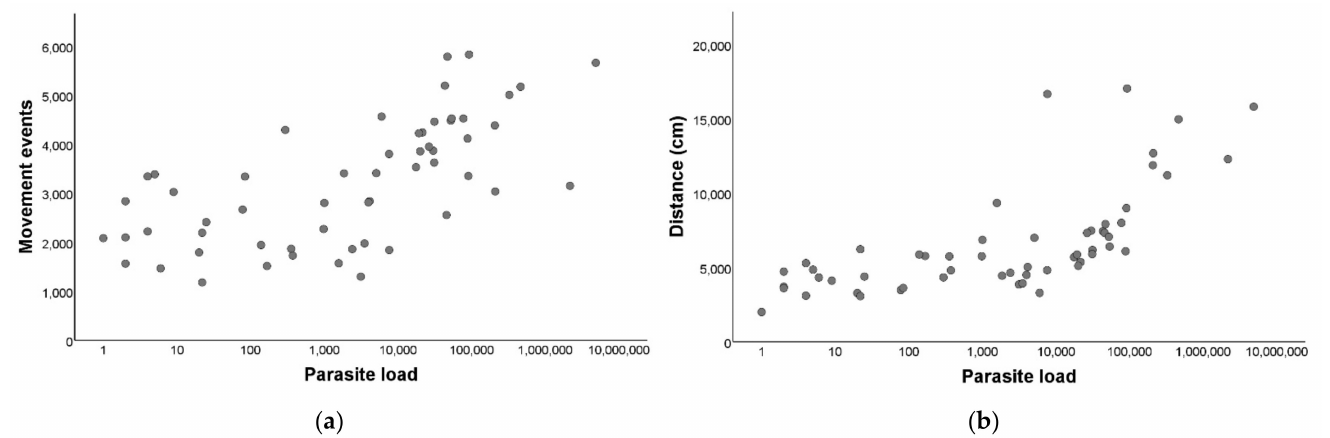
Figure 3. Locomotor activity in relation to Trypanosoma cruzi parasite load of Triatoma infestans . ( a ) Parasite load (LOG 10 ) in relation to the number of movement events during 24 h. ( b ) Parasite load (LOG 10 ) in relation to the distance traveled in centimeters during 24